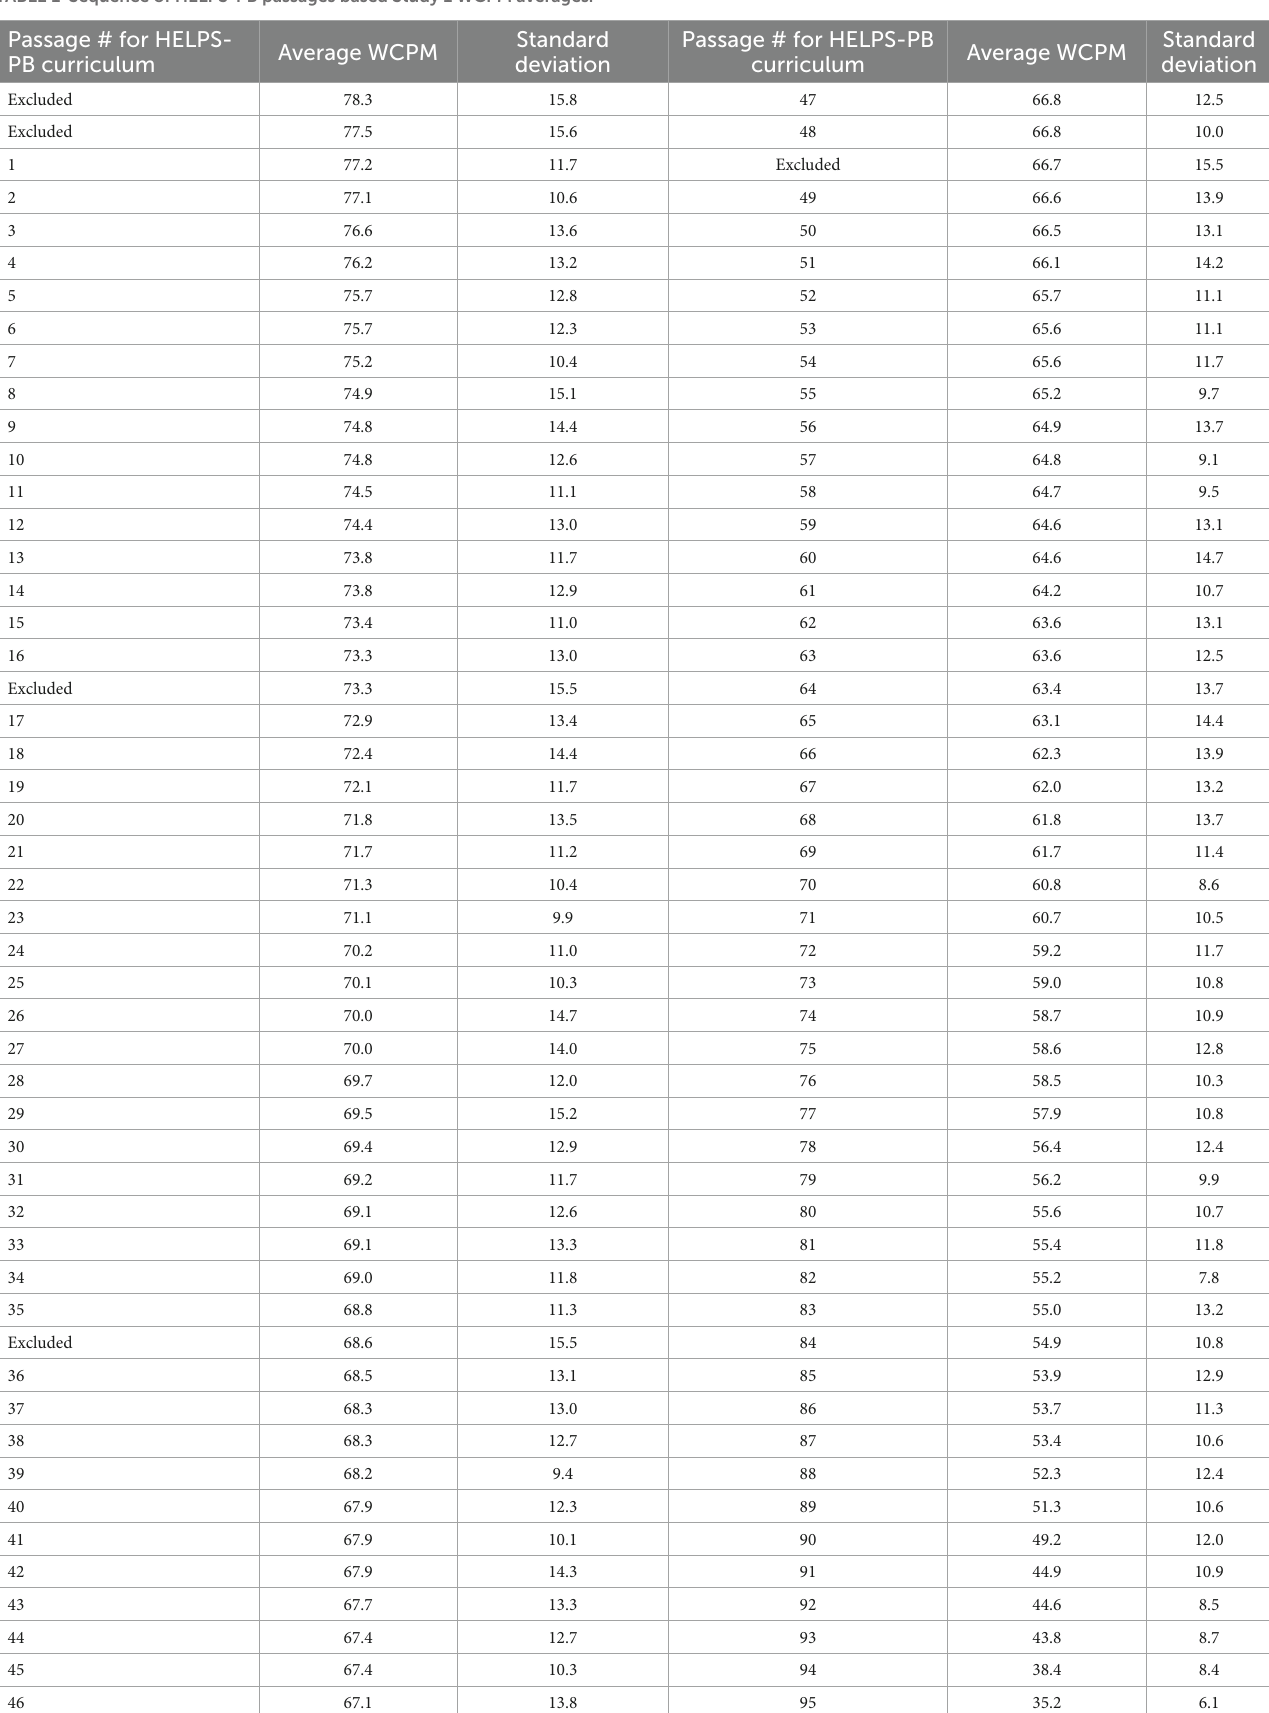
TABLE 1 Sequence of HELPS-PB passages based Study 1 WCPM averages. Passage # for HELPS- PB